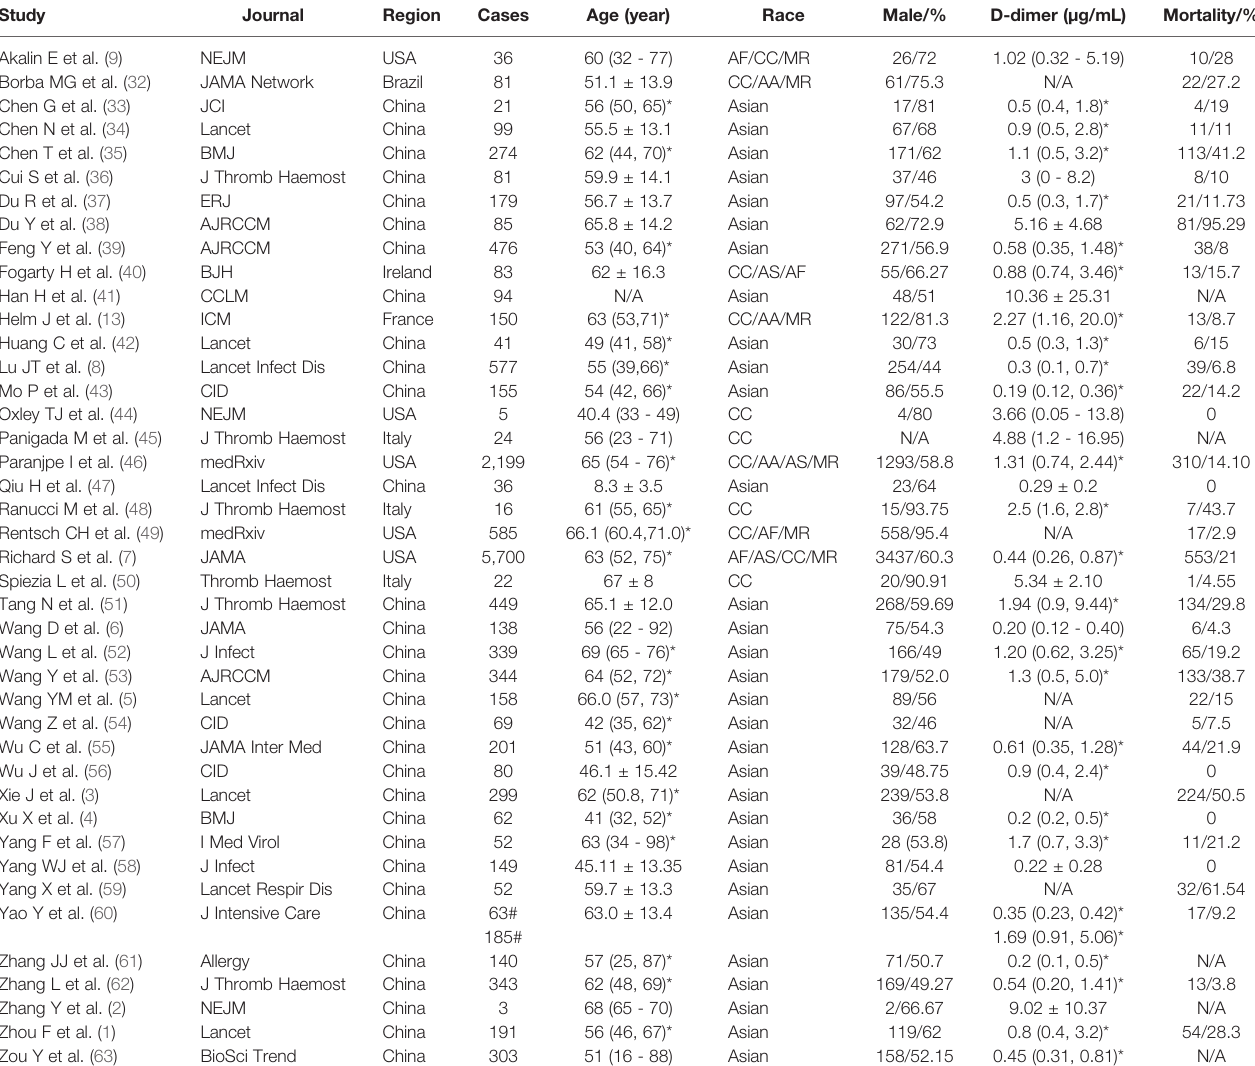
TABLE 1 | Demographic features of the analyzed 42 studies. *IQR. Mean ± S.D. # normal and D-dimer elevated group. (-) range from minimum to maximum.